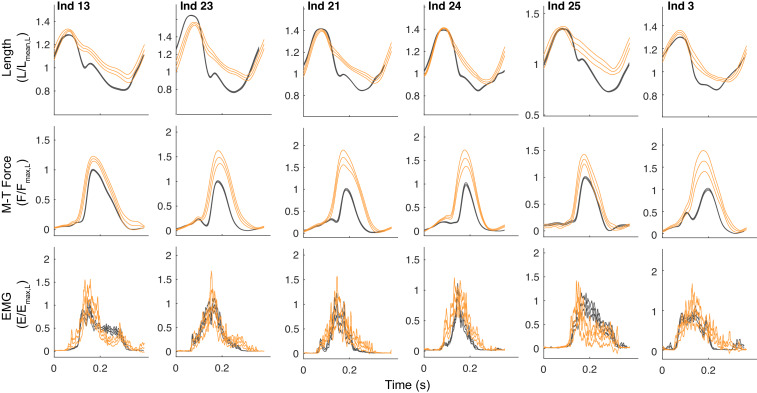
Muscle trajectories during obstacle negotiation for all individuals in the reinnervated cohort.Average stride cycle trajectories (mean ±95% ci) for fascicle length, muscle-tendon force and myoelectric activity (EMG) during obstacle encounter strides (S 0, orange) compared to the level terrain mean (grey), for all birds with reinnervated LG. Although the deviations in length and force during obstacle encounters are similar across individuals, the shifts in EMG activity in the latter half of stance vary substantially across individuals, with some individuals showing reflex inhibition (Ind 13, Ind 25) and others showing reflex excitation.